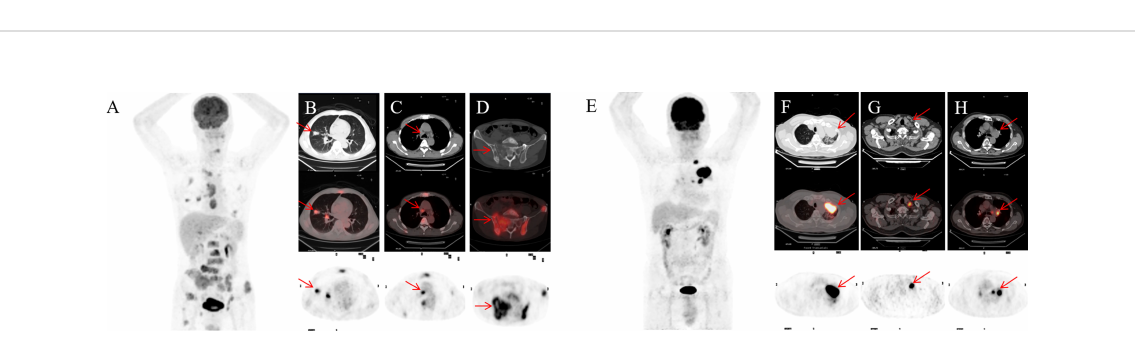
FIGURE 4 A 55-year-old male NSCLC patient with a history of smoking (A) . Before treatment, 18F-FDG PET-CT revealed lesions in the right upper lobe and lymph node and pelvic bone metastases (B-D) . After 4 months of targeted therapy, the patient died. A 67-year-old male NSCLC patient with a smoking history (E) . Before treatment, 18F-FDG PET-CT found lesions in the upper lobe of the left lung, mediastinal and hilar lymph node metastasis (F-H) . At 11 months after targeted therapy, the patient ’ s disease